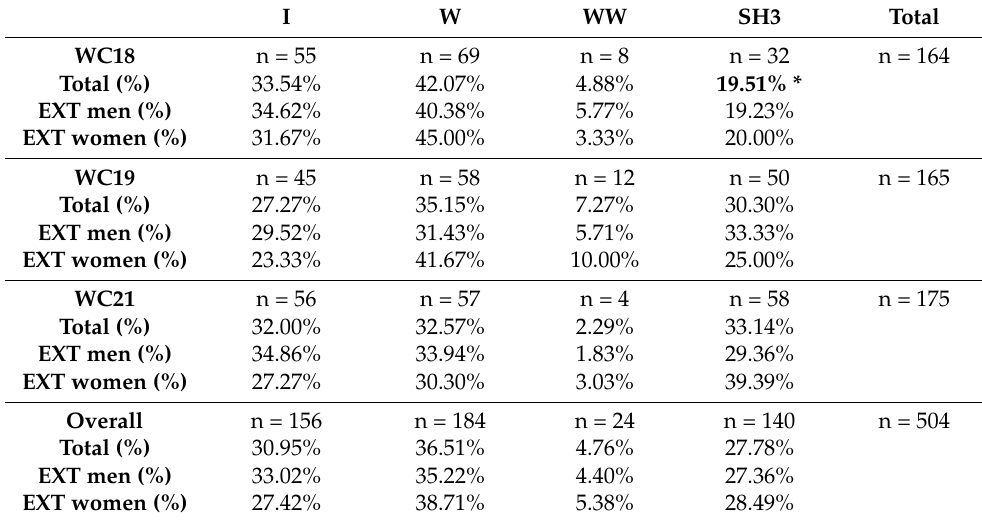
Table 4. Relation between HwCE (I, W, WW or SH3) and the championship (WC18, WC19 and WC21) in contests finishing in the extended time of the golden score period (EXT) (n = 504).